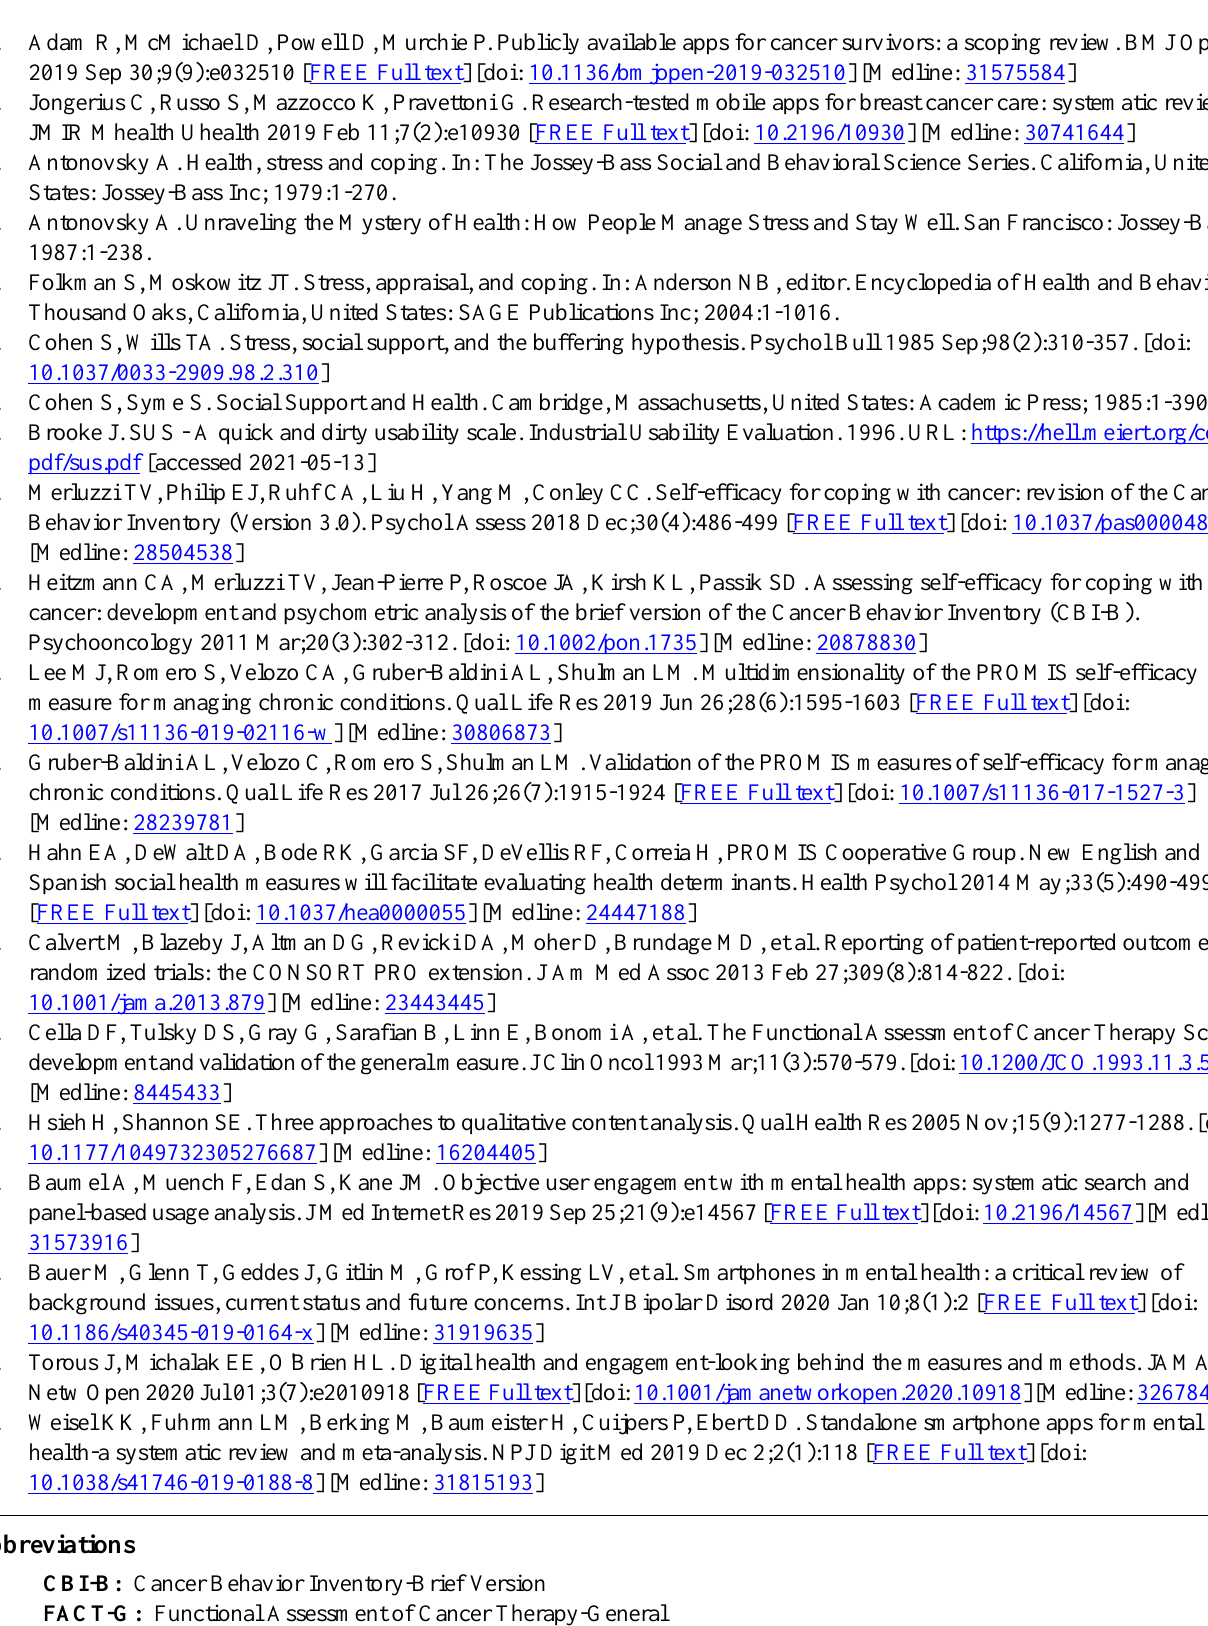
Abbreviations CBI-B: Cancer Behavior Inventory-Brief Version FACT-G: Functional Assessment of Cancer Therapy-General PROMIS: Patient-Reported Outcomes Measurement Information System REDCap: Research Electronic Data